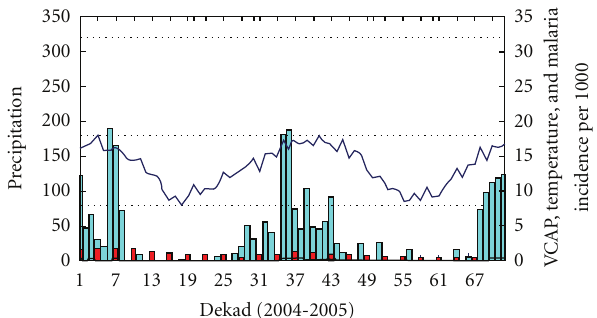
Figure 9: Region 2: the black line represents the VCAP values (very low values close to 0), the blue bar represents rainfall (mm/dekad with values reaching 200 mm), the blue line represents temperature (temperature below 18 ◦ C), and the red bar represents malaria incidence per 1000